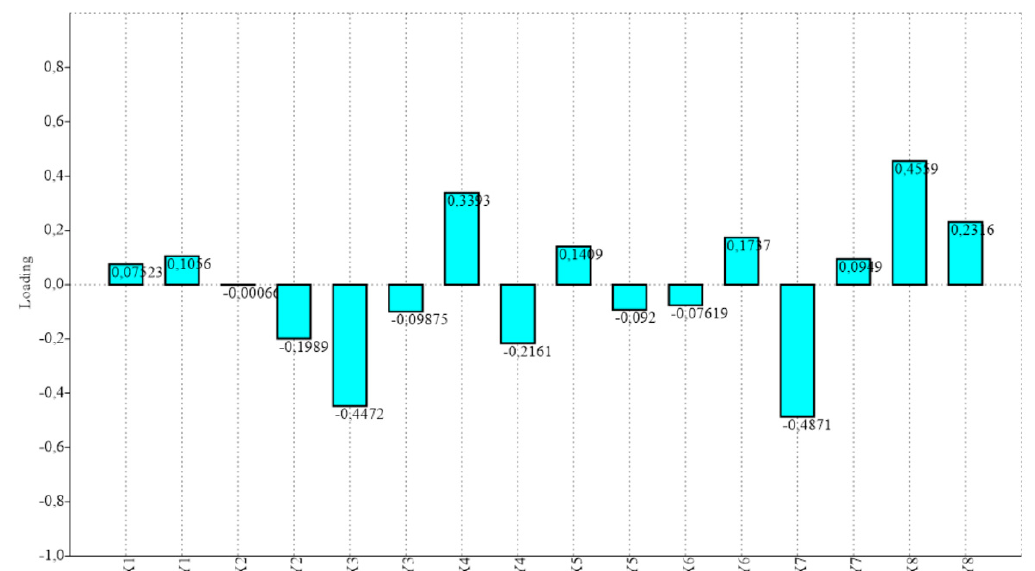
Figure 3. Screen plot showing the proportion of the total shape variance explained by each PC for 17 pairs of distal forelimbs belonging to Pyrenean Brown calves. There was a gradual decrease in the percentage of variance. The first two PCs accounted for 46.80% of the total variation.